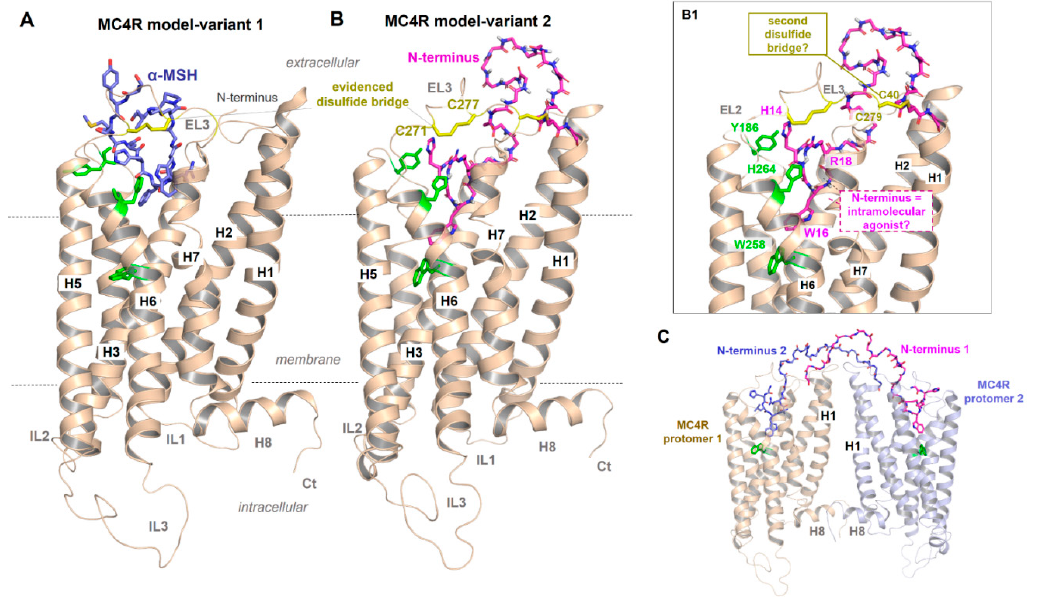
Figure 3. Presumed MC4R active-state models. ( A ) Independent of various details, this receptor shows structural features that are common for GPCRs such as seven transmembrane helices (H1–7) and corresponding connection loops (extracellular loops, EL1-3, and intracellular loops, IL1-3), the additional membrane surface helix H8 as well as the N-terminus (Nt) and C-terminus (Ct). As recently proposed [39], α -MSH may bind into a crevice between EL1, EL2 and EL3 and transitions to the transmembrane helices. A disulfide bridge (yellow sticks) in the EL3 has also been proposed for the MC2R [85]. ( B ) The second MC4R model variant is intended to show how parts of the N-terminus (magenta, sticks) might interact as intramolecular ligands, which should lead to a permanent basal signaling activity as previously proposed [65,79]. Details of this interaction [79] are shown in ( B1 ) (labeled side chains, green for MC4R, magenta for the N-terminus). In addition, a second previously proposed disulfide bridge in the extracellular region should be located between the N-terminus (C40) and the EL3 (C279), whereby alanine mutations of these two cysteines have no impact on MC4R functionalities [86]. In the solved inactive-state crystal structure of MC4R [21], no disulfide bridge between C40 and C279 can be observed, only between C271 and C277 in EL3. ( C ) It would also be hypothetically conceivable that in an MC4R homodimer (see oligomerization section below), the N-termini between the two individual monomers transinteract from one to the other, respectively, in contrast to a monomeric receptor constellation ( cis activation ( B1 )).